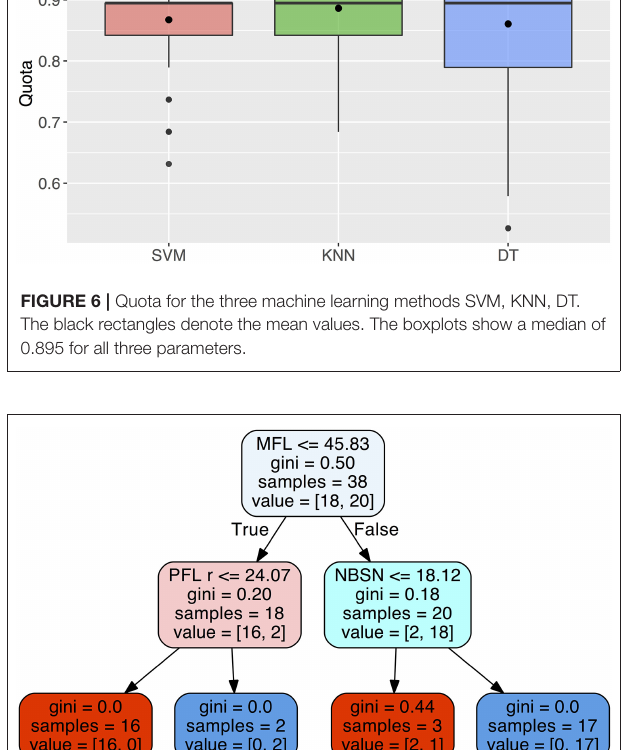
0.842, 75% quantile 0.895) ( Figure 6 ). For this method,